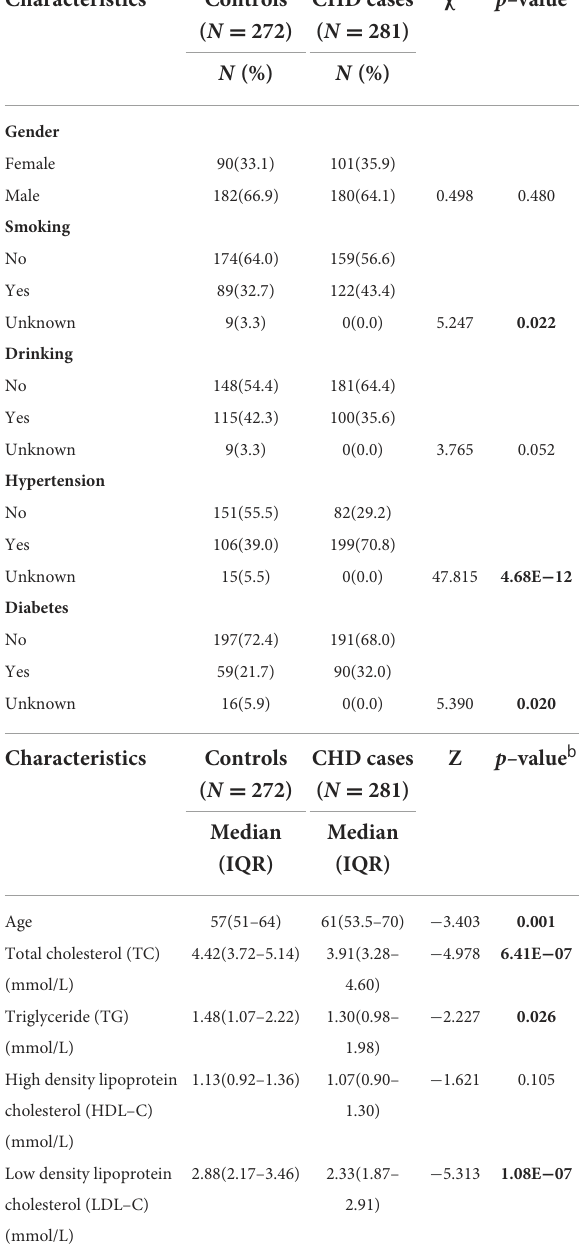
TABLE 1 Baseline characteristics of coronary heart disease (CHD) patients and